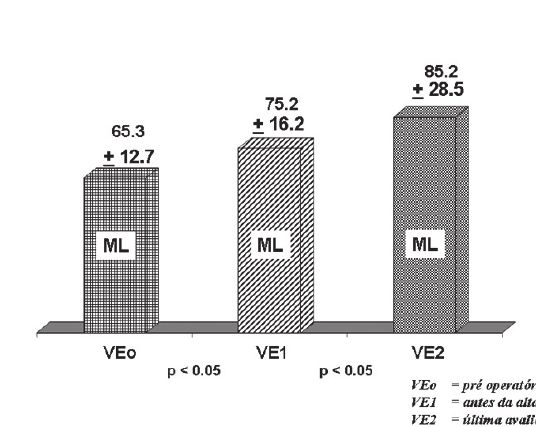
Fig. 4 - Volume de ejeção no pré-operatório, antes da alta hospitalar e seis meses após a operação